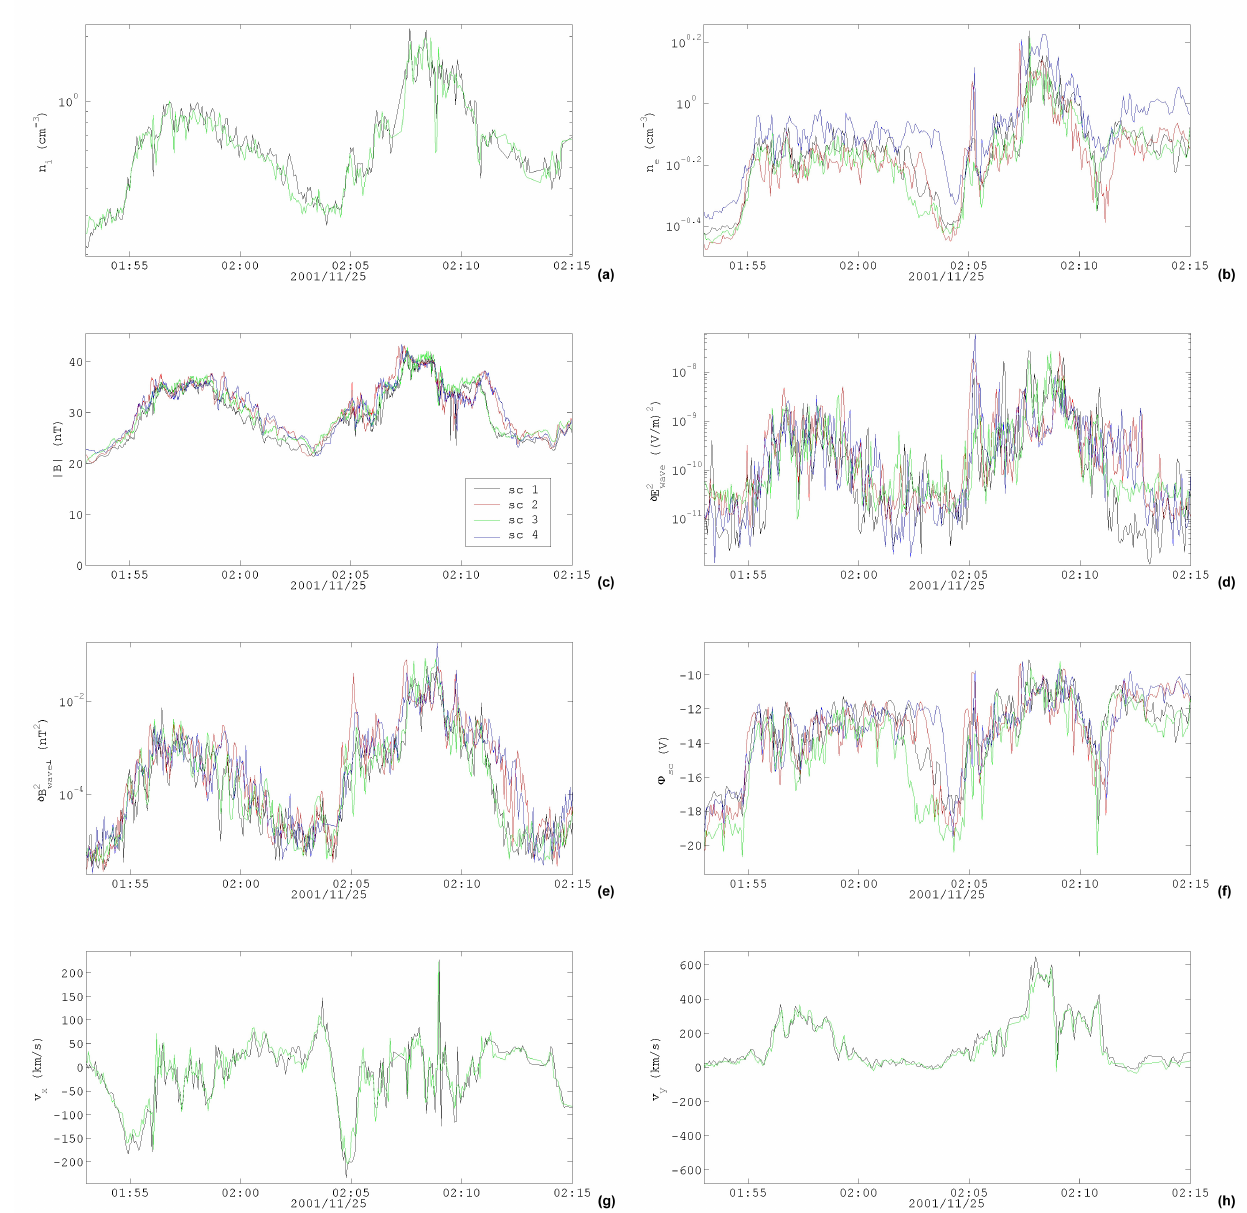
Fig. 4. Time profiles used for the reconstruction of two wave periods on 25 November 2001. ( a ) Ion density (CIS/HIA). ( b ) Electron density (PEACE). ( c ) Magnetic field strength (FGM). ( d ) Electric wave intensity 2–80kHz (WHISPER). ( e ) Perpendicular magnetic wave intensity 0.3–10Hz (STAFF). ( f ) Spacecraft potential (EFW). ( g ) Ion velocity v x (non-moving frame, CIS/HIA). ( h ) Ion velocity v y (non-moving frame,